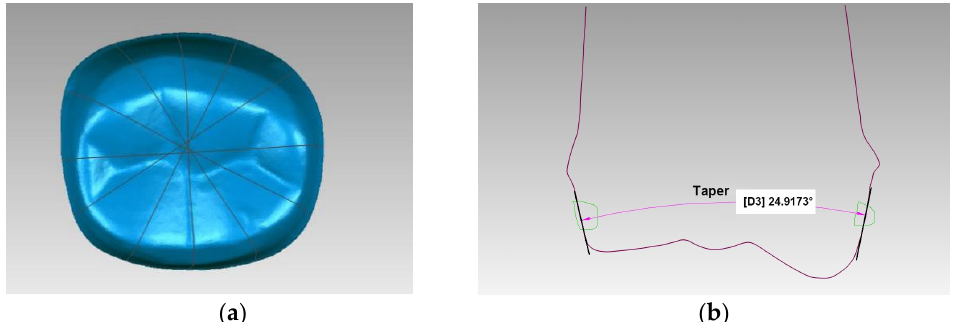
Figure 5. Six vertical planes of the tooth preparation ( a ); measurement of the taper of a resin tooth preparation in Geomagic Qualify ( b ).